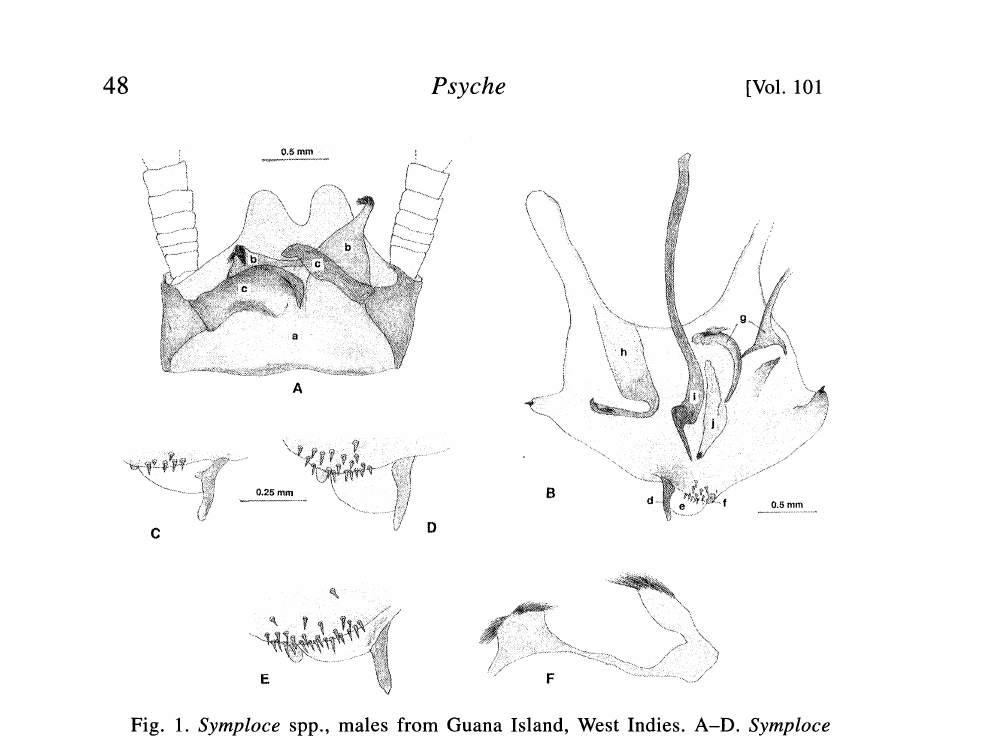
Fig. 1. Symploce spp., males from Guana Island, West Indies. A-D. Symploce pararuficollis paratype: A. supraanal plate, paraprocts, and intercercal plate (ven- tral); B. subgenital plate and genitalia (dorsal); C, D. apexes of 2 subgenital plates showing styli, interstylar lobe, and variation in number of spines (ventral); E, F. Symploce ruficollis: E. apex of subgenital plate (ventral); F. intercercal plate (ven- tral). Abbreviations: a, supraanal plate; b, intercercal plate; c, paraprocts; d, left style; e, interstylar lobe; f, right style; g, sclerites of right phallomere; h, hooklike left phallomere; i, median phallomere; j, membrane associated with median phal- lomere. Figs. E and F drawn to same scale as C and